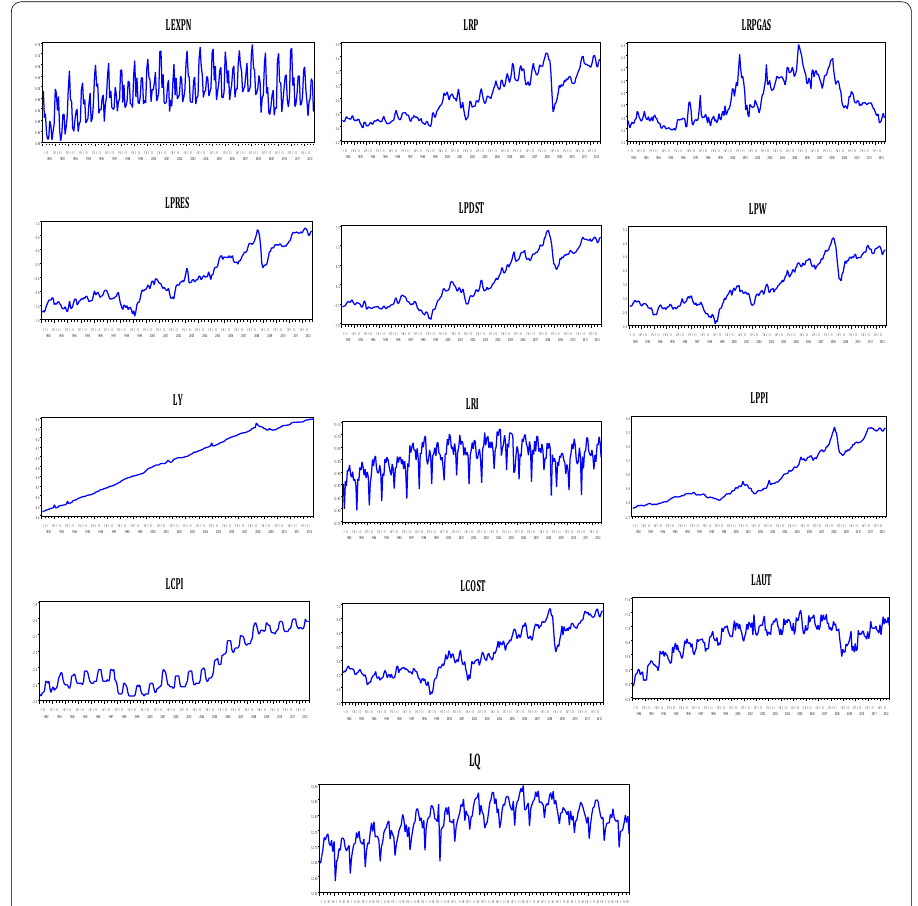
Fig. 1 Plot of LExpn, LRP, LRPGas, LPRes, LPdst, LPW, LY, LRI, LPPI, LCPI, LCost, LAUT and LQ in the